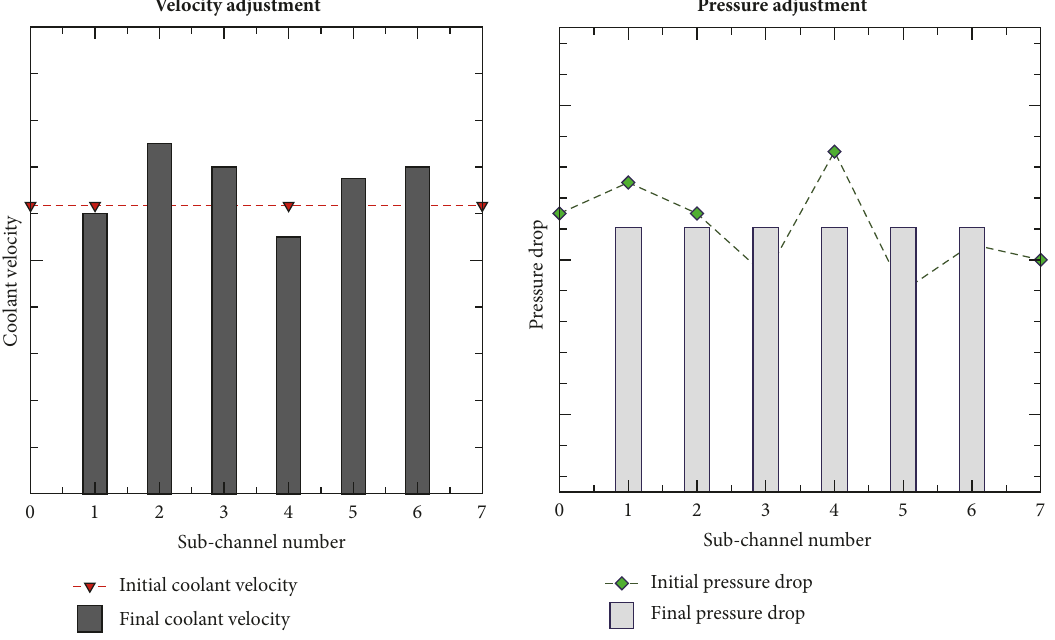
Figure 3: Model of mass flow rate distribution used in COTENP